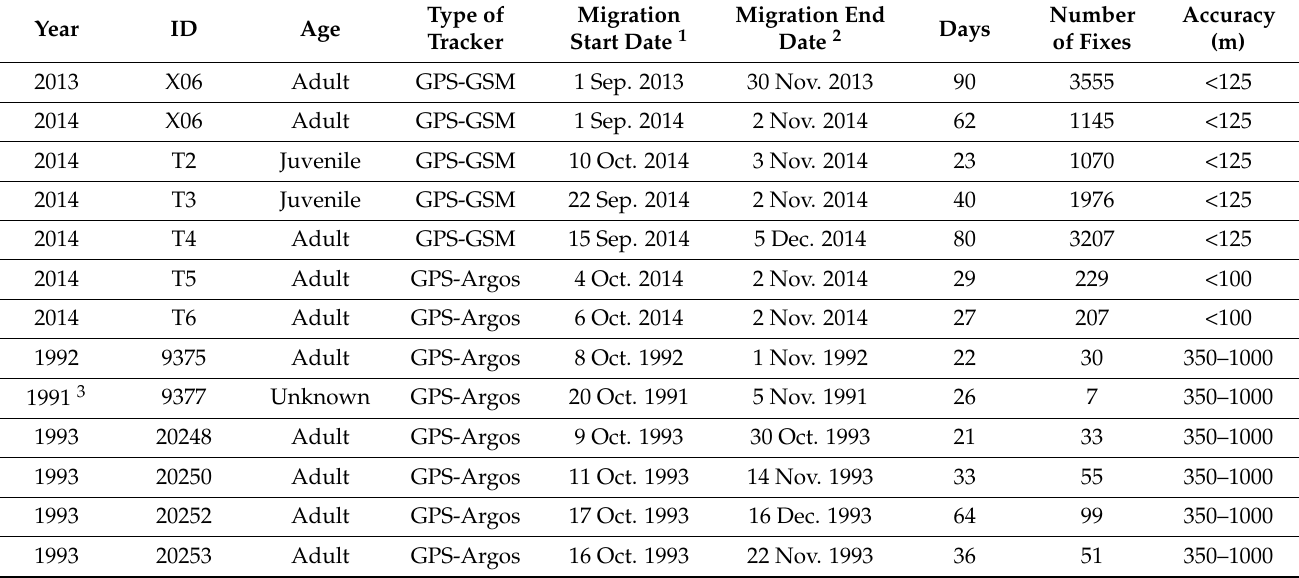
Table 1. Information on the tracked white-naped